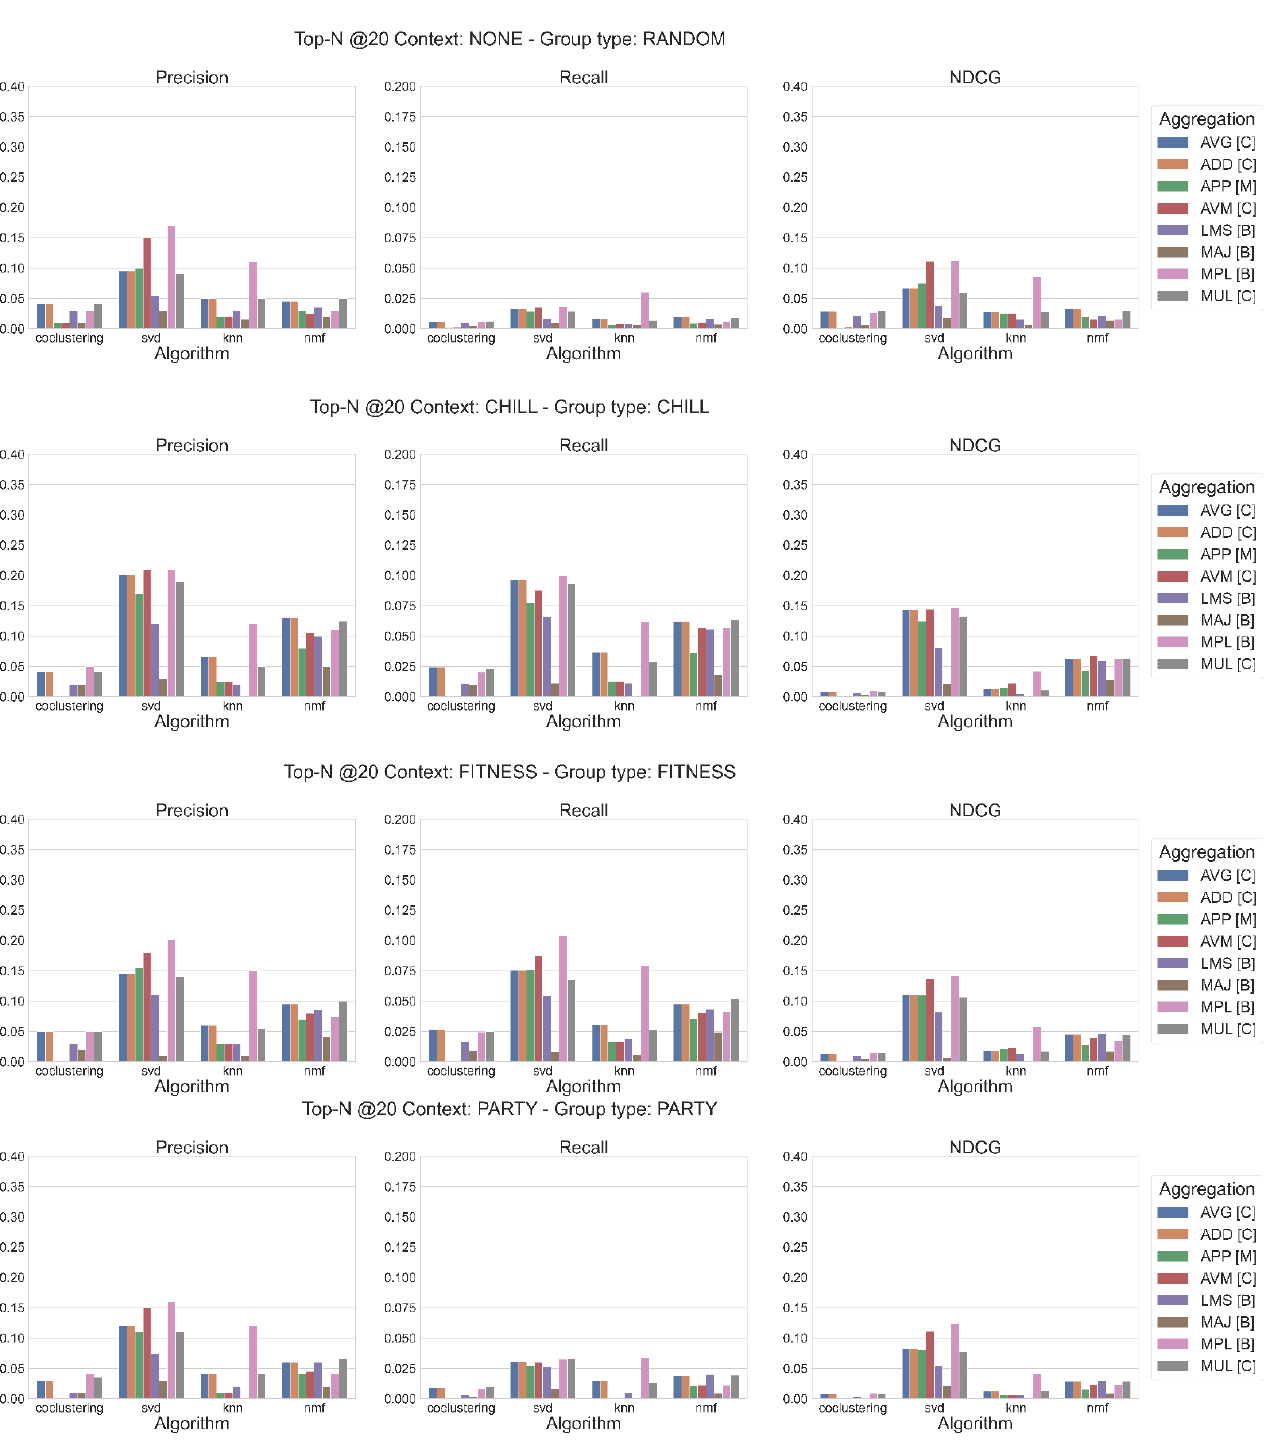
Figure 5. Comparison of metrics, based on aggregation methods, and algorithms for a fixed context in top-n@20 recommen- dations for